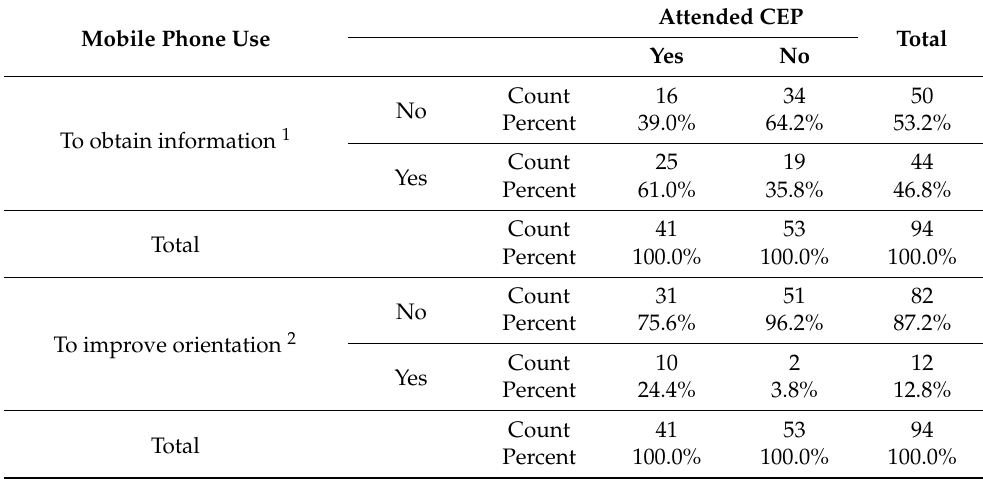
Table 14. Association between attendance of Coding Educational Programs and type of activity for which the mobile phone is